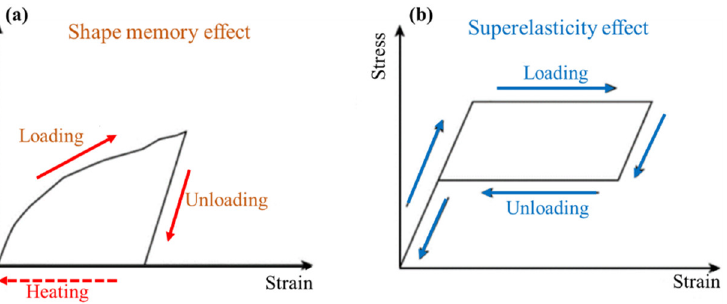
Figure 1. Representation of the difference between ( a ) shape memory effect and ( b ) superelasticity in the tensile stress-strain curve.